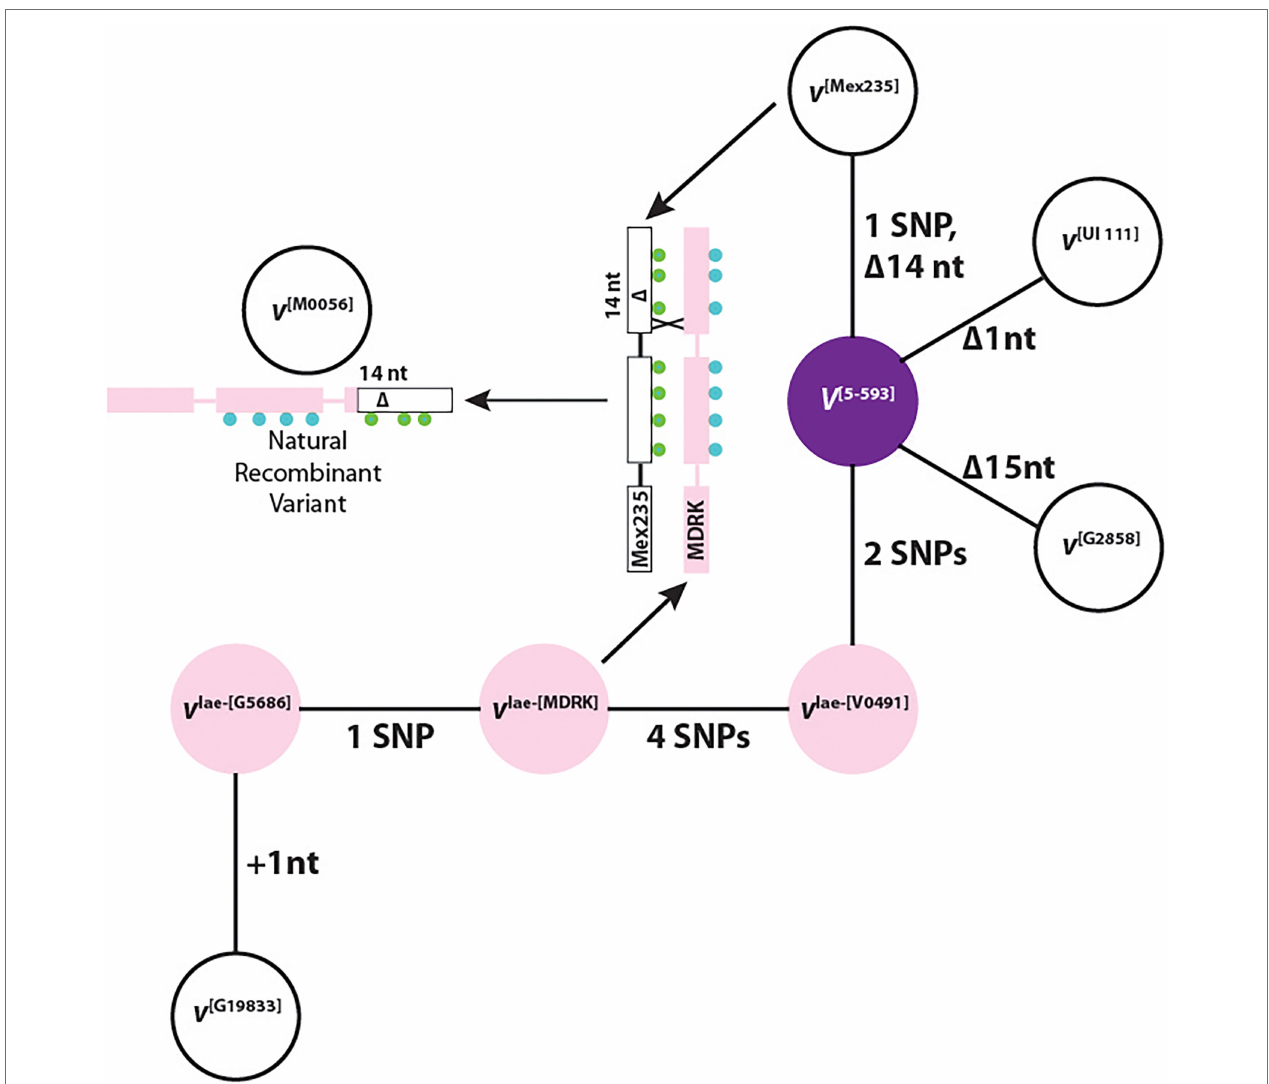
FIGURE 4 | A haplotype phylogenetic network of dominant ( V ) and recessive ( v , v lae ) alleles. The colors represent the flower color of each genotype. The representative genotype for each haplotype is in bracketed superscript. +, a nucleotide insertion; Δ , a nucleotide deletion. The green and blue circles represent the SNP differences between the v [Mex235] and v lae-[MDRK] haplotypes, respectively. The number preceding “SNP” indicates the number of single nucleotide polymorphism (SNP) differences between neighboring